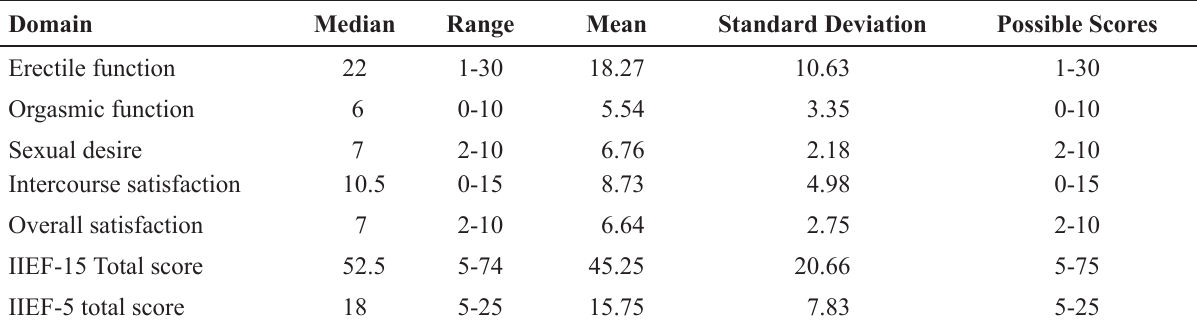
Table 1 – Male patient IIEF-15 and IIEF-5 scores after surgical treatment of prostate cancer.